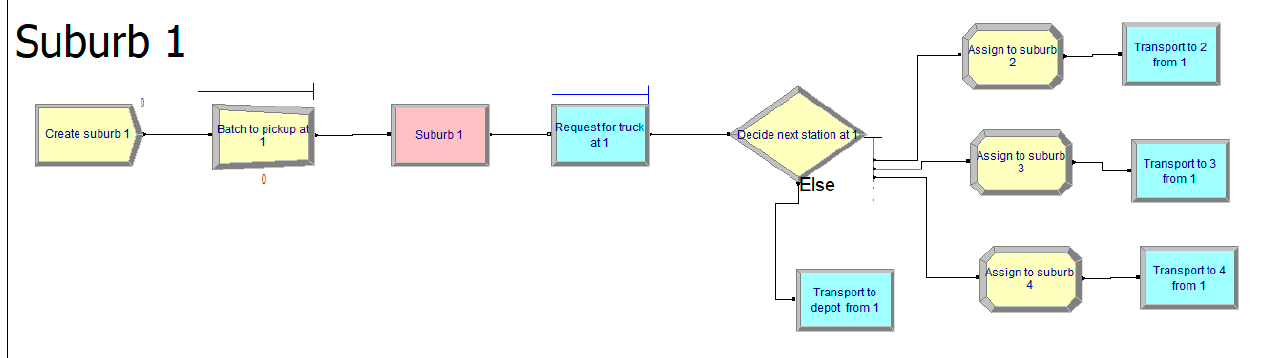
Figure 11. Refined schematic representation of the transportation network.